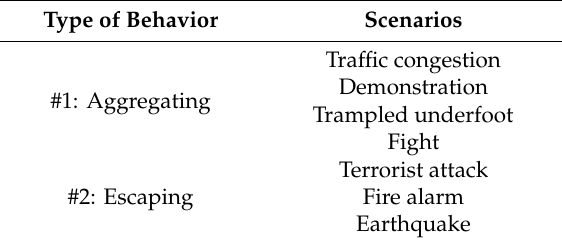
Table 3. Scenarios applied for each type of crowd behavior.